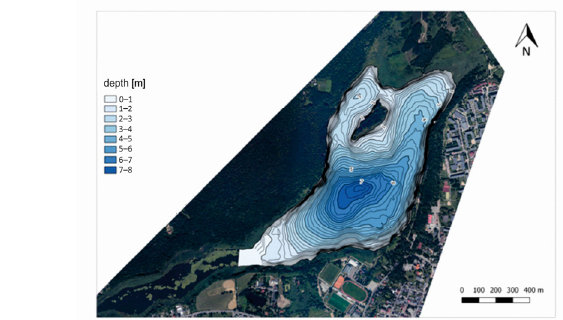
Figure 3. Measurement points located on Lake Swarz ę dzkie ( left )-the red rectangle indicates the study area, the blue colour represents the water surface, the green the islands; bathymetric plan of the lake [40] ( right ).